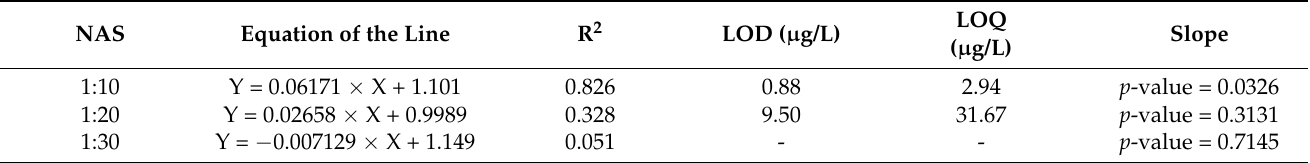
Figure 3. Detection assays of AFB1 in acetonitrile. ( A ) Colorimetric response of the NAS using different wavelengths in AFB1-containing samples (at MRL concentration) and controls of AFB1-free samples. ( B ) Colorimetric response using AuNPs:aptamer molar ratios of 1: 10 (red), 1:20 (blue), and 1:40 (green) for detection of AFB1 at concentrations of 0, 1, 2, 5, and 10 ug/L. ( C ) Statistical analysis of the colorimetric response of NAS 1:10 molar ratio as a function of AFB1 concentration by using the Kruskal–Wallis test; ( D ) Linear fitting of the colorimetric response data as a function of the AFB1 concentration of NAS 1:10 molar ratio. Asterisks denote statistically significant differences between the treatments and controls. * p < 0.05, ** p < 0.001 and **** p < 0.0001. Non-significant differences are indicated as ns. Table 1. Sensibility parameters for AFB1 detection with NAS using different AuNP:aptamer